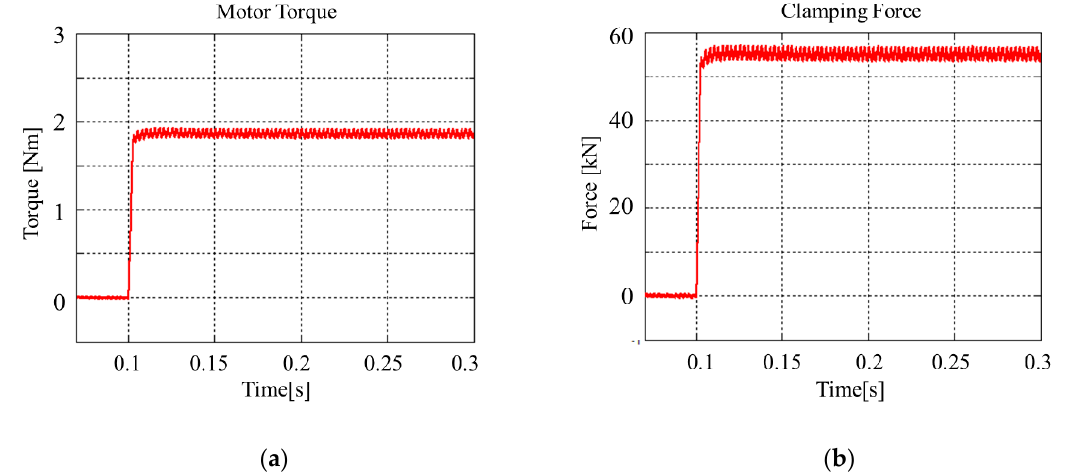
Figure 10. Simulation result of current control output with MTPA: ( a ) q-axis and ( b ) d-axis.